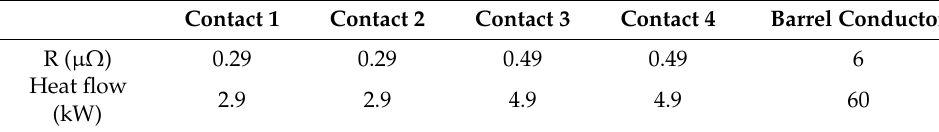
Figure 1. Structure of the integrated type pyro-breaker. Table 1. Resistance and heat flow of the electrical contacts and the barrel conductor.